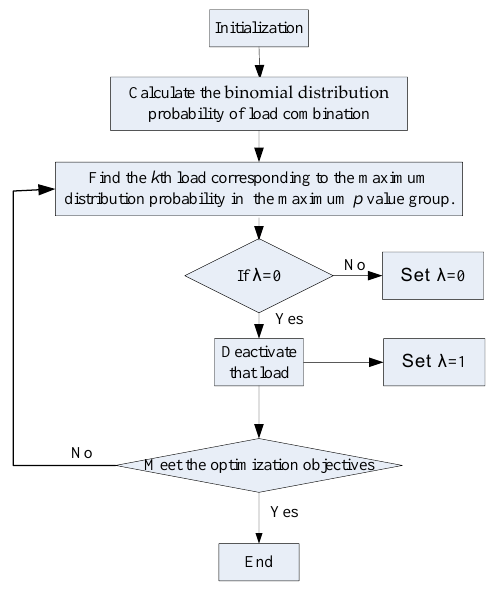
Figure 7. The flow chart of DSR.